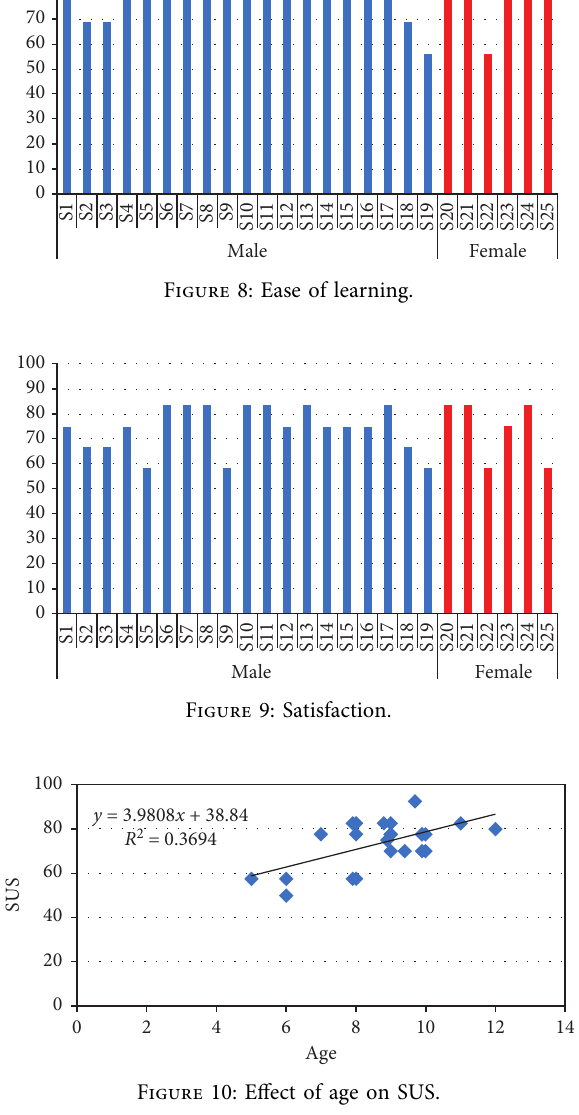
Figure 10: Effect of age on